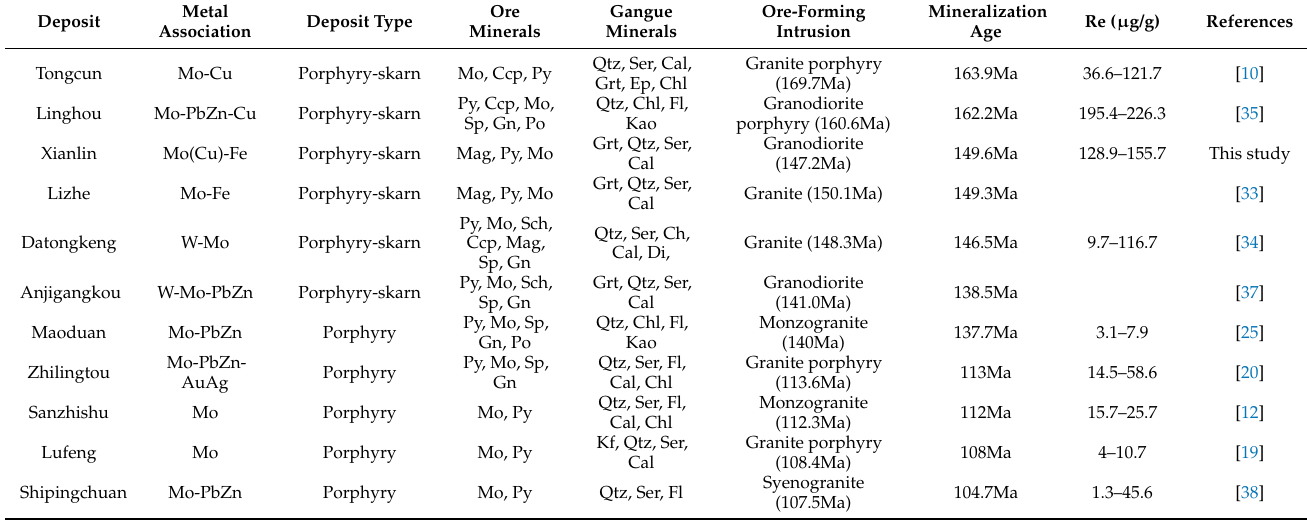
Table 3. The characteristics of Mo polymetallic deposits in the Zhejiang province, South China Mo